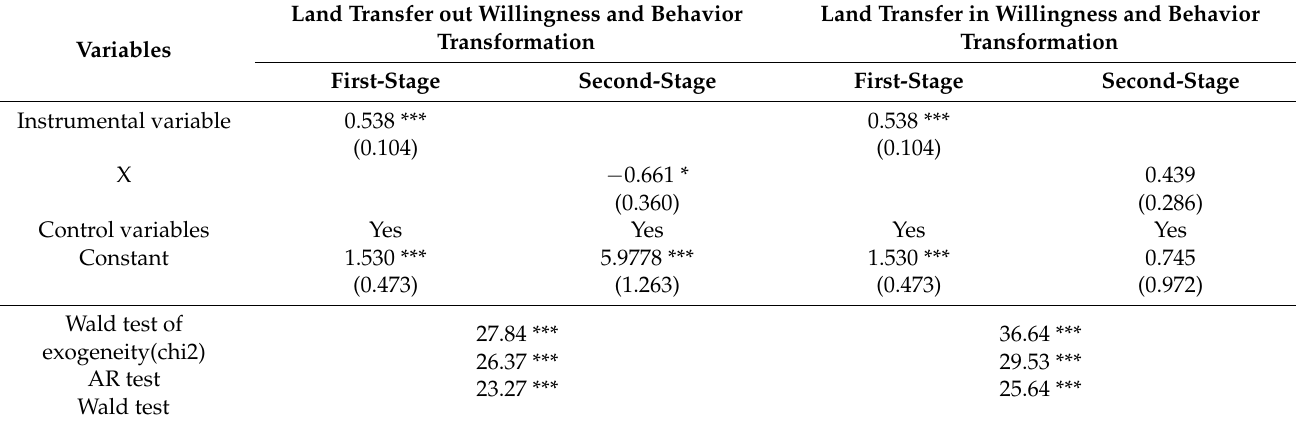
Table 6. Results of Endogeneity Analysis: IV-probit